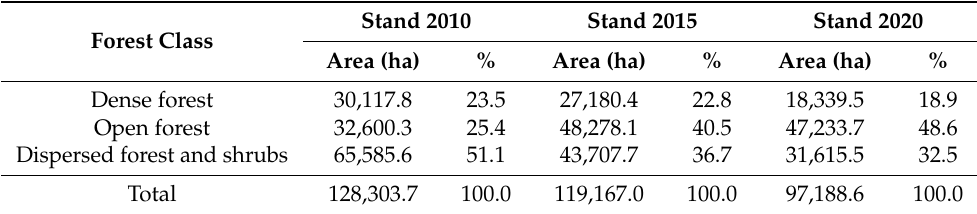
Figure 6. Distribution of changes in forest cover in the Syrian coast region from 2010–2015 ( a ), 2015–2020 ( b ), and 2010–2020 ( c ). Table 8. Area (ha) and proportion (%) of forest cover classified by density in the study area from 2010 to 2020 region (after computing adjusted area estimates).